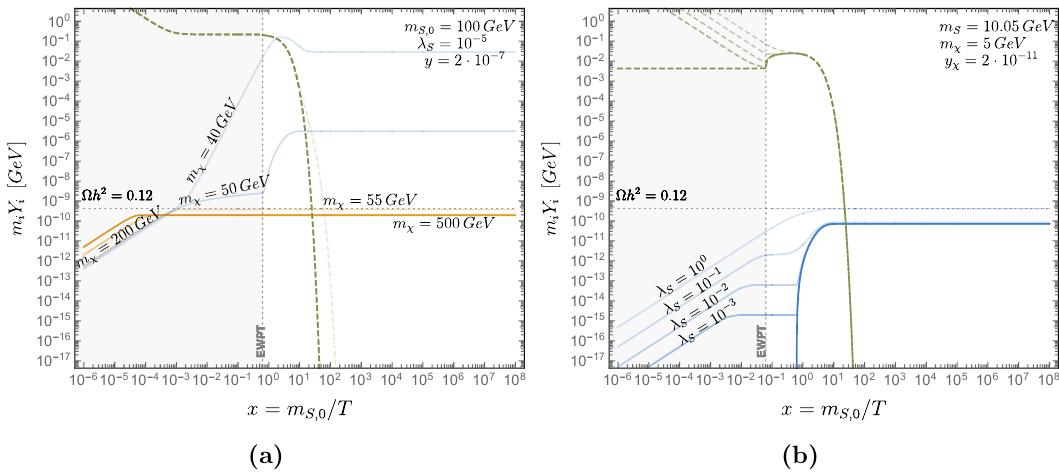
Figure 6. (a) A transition between the standard and the forbidden freeze-in regimes. In the former (blue solid lines) the (cid:12)nal abundance depends strongly on the m